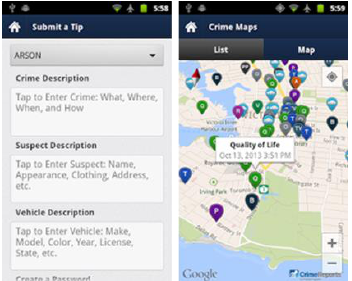
Figure 6: the Mobile-Vic